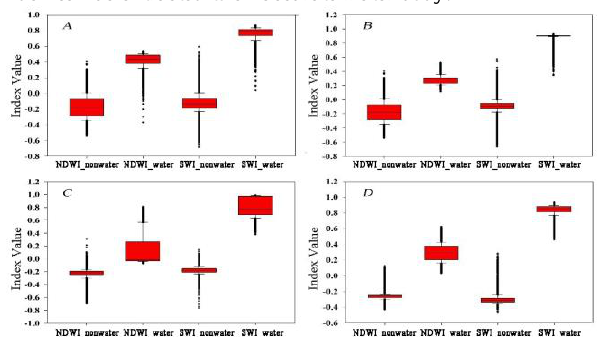
Table 2. Mean value and its contrast value of water and not water Figure 3 is the statistical map of the maximum, minimum, mean and standard deviation of water and not water samples regarding to NDWI and SWI. A, B, C and D are the experimental areas of Taihu, Yangtze River Estuary, ChaKa Saline Lake, and Chain Lake. From the figure 3, we can see that NDWI and SWI can distinguish most of the water and not water area, however, the maximum or minimum value of the not water body of the NDWI index is almost intersecting with the standard deviation of water body, and the maximum or minimum value of the not water body of the SWI index is not intersecting with the standard deviation of the water body. Therefore, the extraction of water body using NDWI index is easy to produce a large number of misclassification. The SWI index can be extracted to an accurate water body.